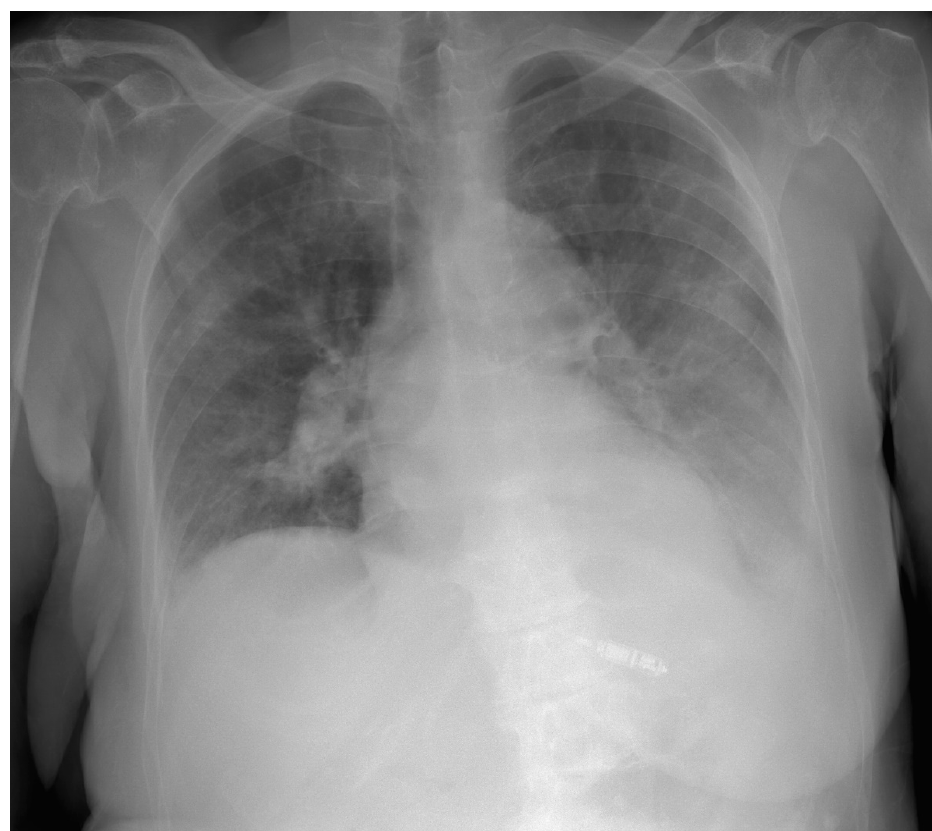
Figure 2. Chest X-ray in posteroanterior view with implanted leadless pacing system in the interventricular septum in the right ventricle.